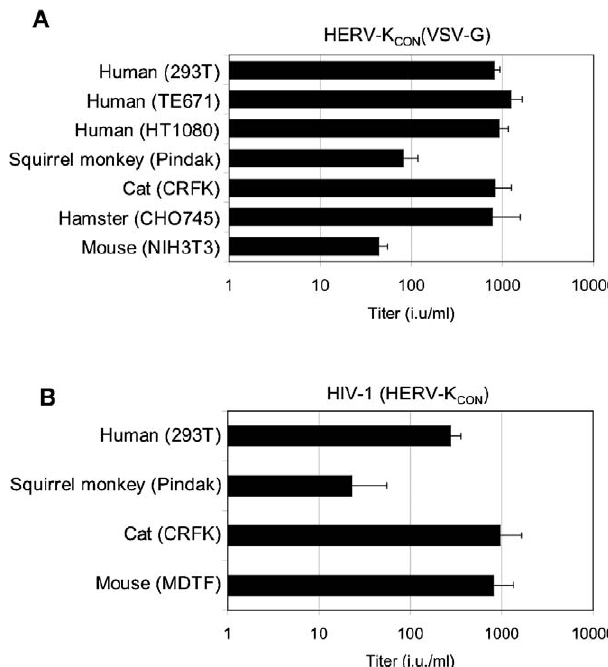
Figure 5. HERV-K CON Tropism (A) Human, squirrel monkey, feline, hamster, or murine cells were infected with VSV-G pseudotyped HERV-K CON particles. Two days postinfection, GFP þ foci were quantified microscopically, and titers are expressed as number of infectious units (i.u.) per milliliter of virus- containing supernatant applied. (B) Human, squirrel monkey, feline, or murine cells were infected with HERV-K CON Env pseudotyped HIV-1 particles as in (A). Two days postinfection, GFP-positive foci were quantified. All data are representative of at least three experiments.